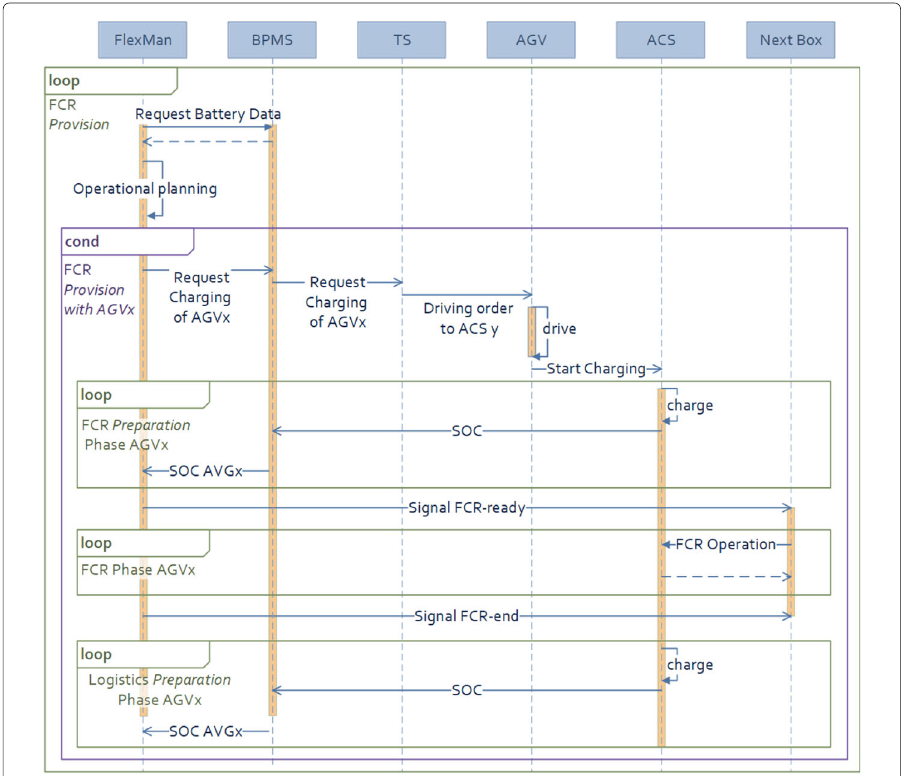
Fig. 5 Sequence diagram of intraday operational phase